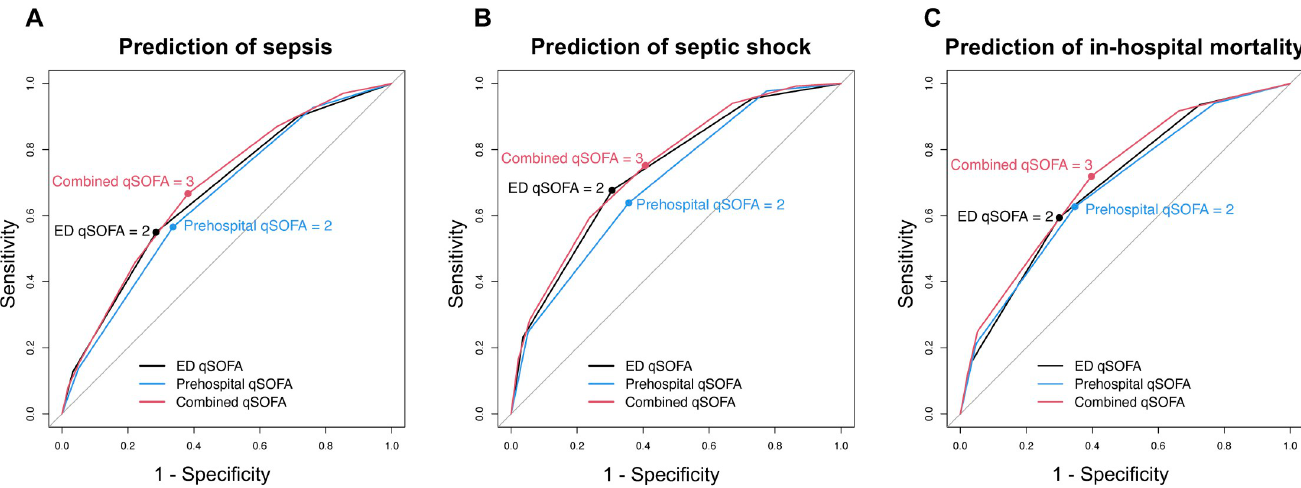
Fig 2. Receiver-operating-characteristics (ROC) curves of qSOFA among patients with clinically suspected infection. (A) Prediction of sepsis (B) Prediction of septic shock (C) Prediction of in-hospital mortality. The corresponding values of the area under the receiver operating characteristics curve for each model (i.e., the c-statistics) are presented in Tables 3–5. Abbreviations: ED, Emergency Department; qSOFA, The quick Sequential Organ Failure